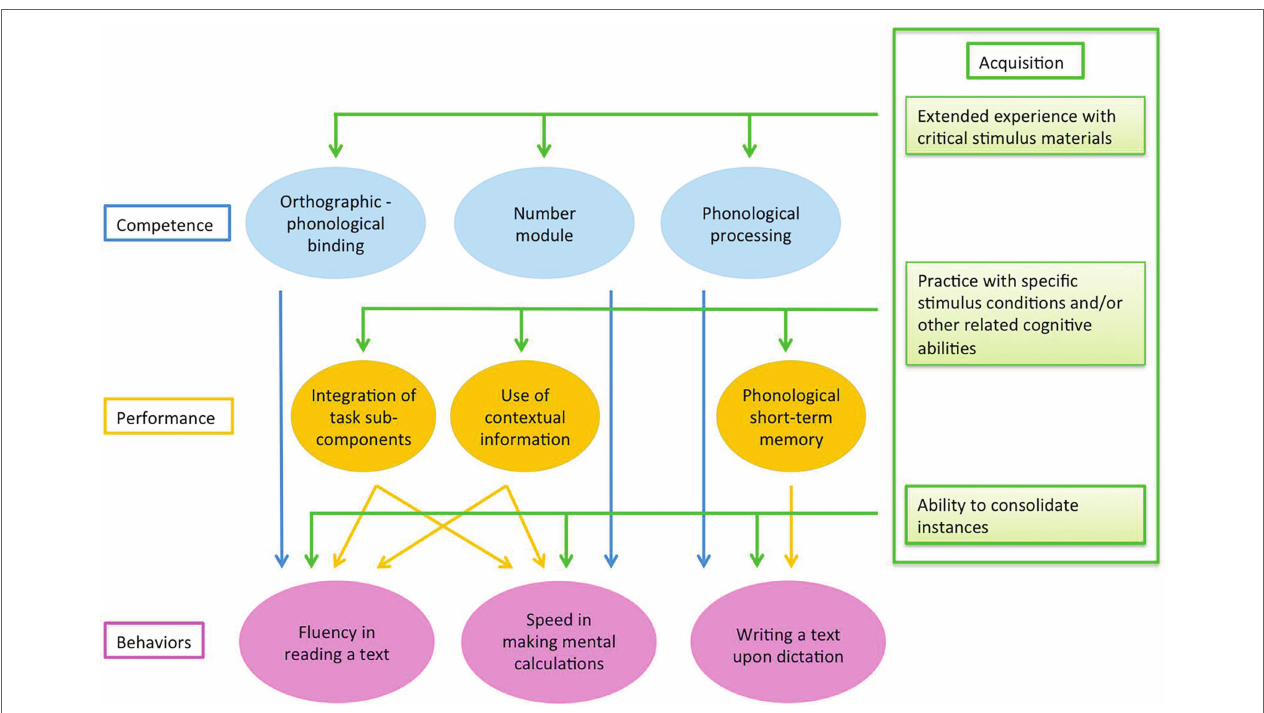
FIGURE 1 | A multi-level model of learning cognitive skills. Target behaviors are expressed in terms of task-specific exemplars (Zoccolotti et al.,